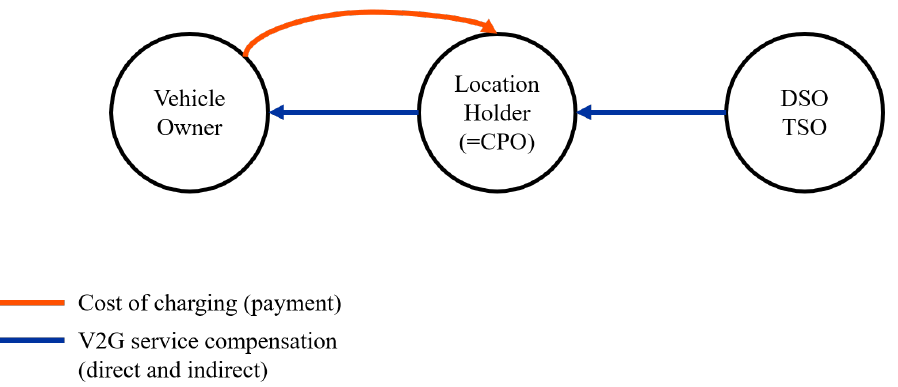
Figure 1. Definition of a private charging case (following [25], own